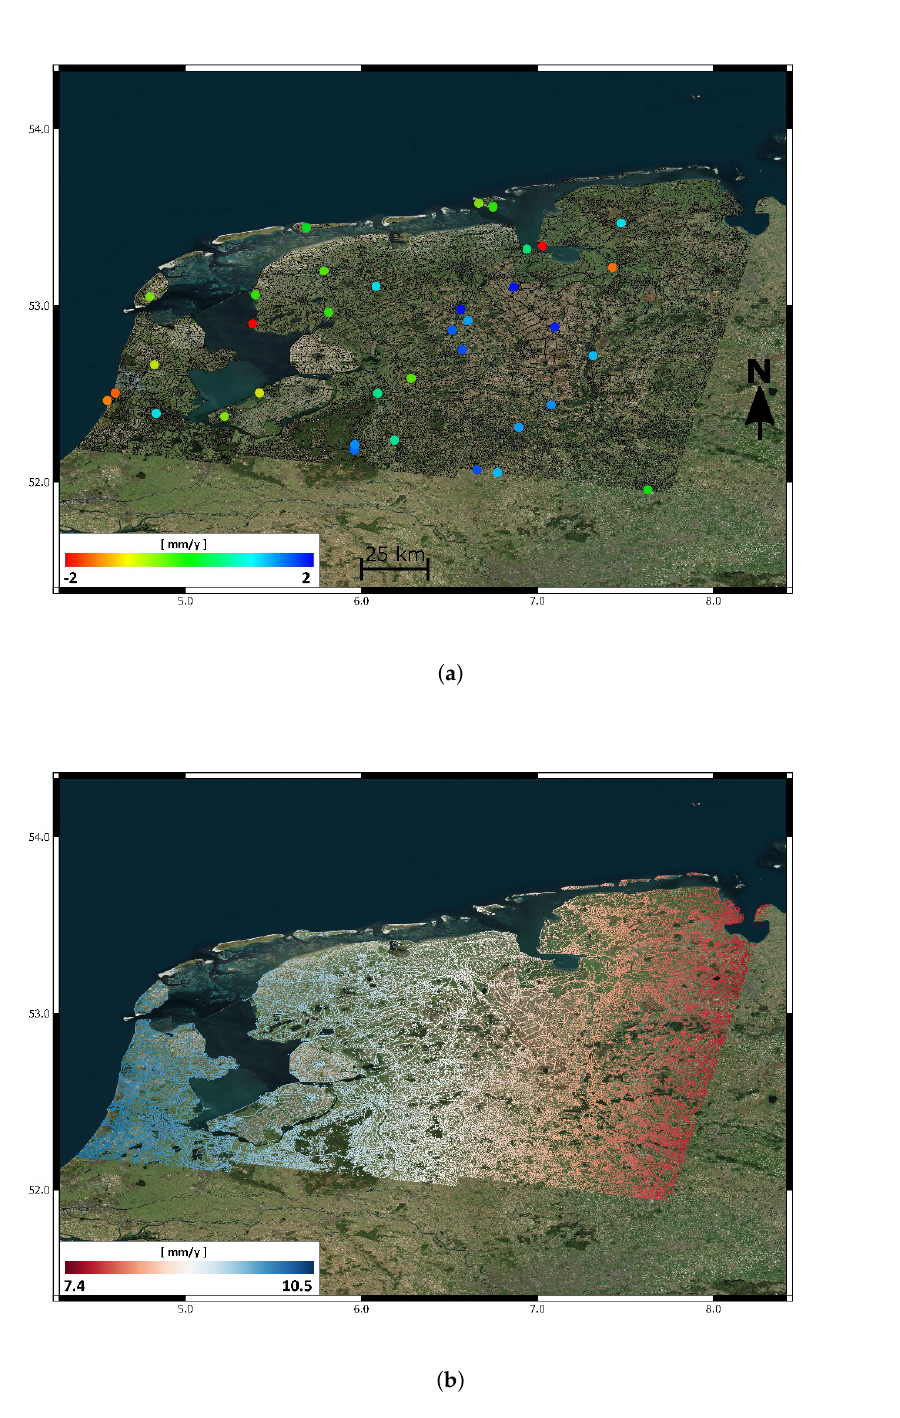
Figure 9. Results for the descending Holland stack, showing ( a ) the measured and color-coded ∆ 0 and ( b ) the removed continental drift